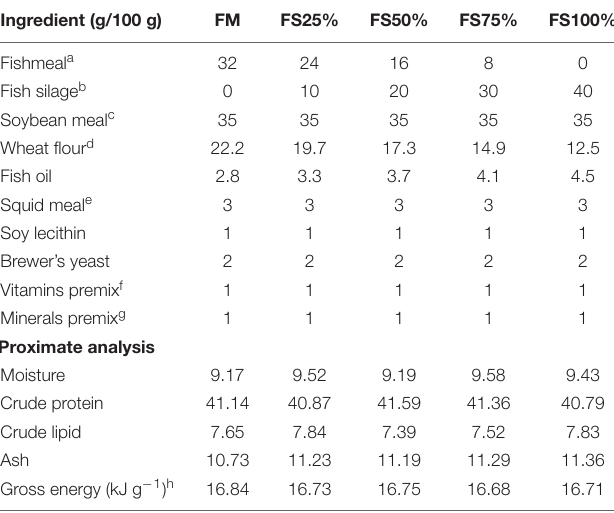
TABLE 2 | Composition and proximate analysis of the experimental diets. Ingredient (g/100 g)